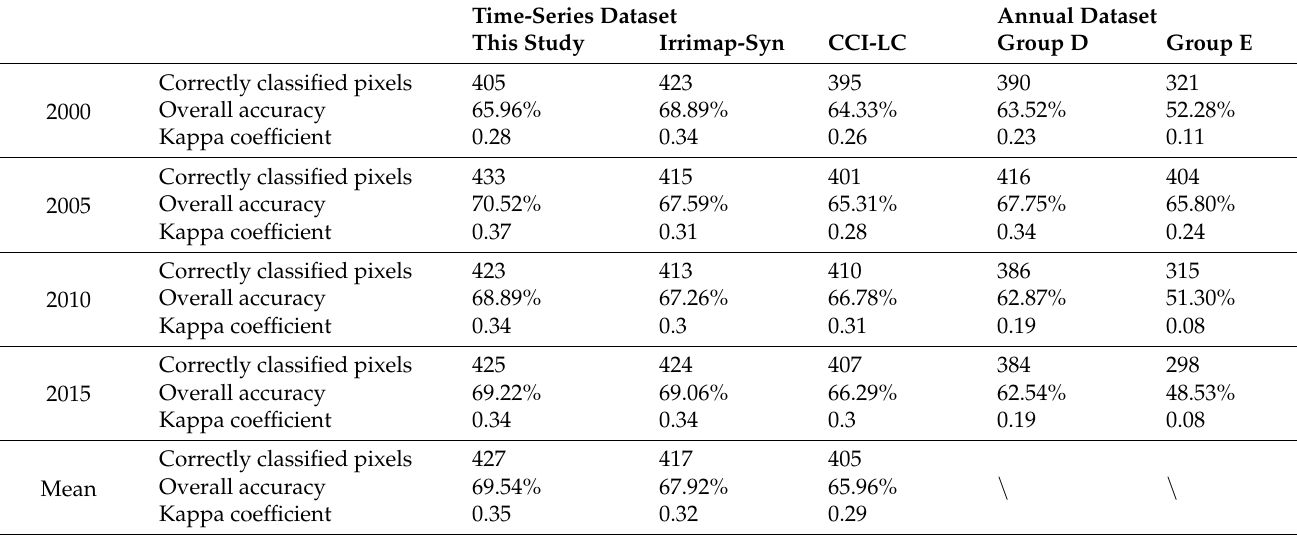
Table 4. The accuracy assessment of this study and comparison with other